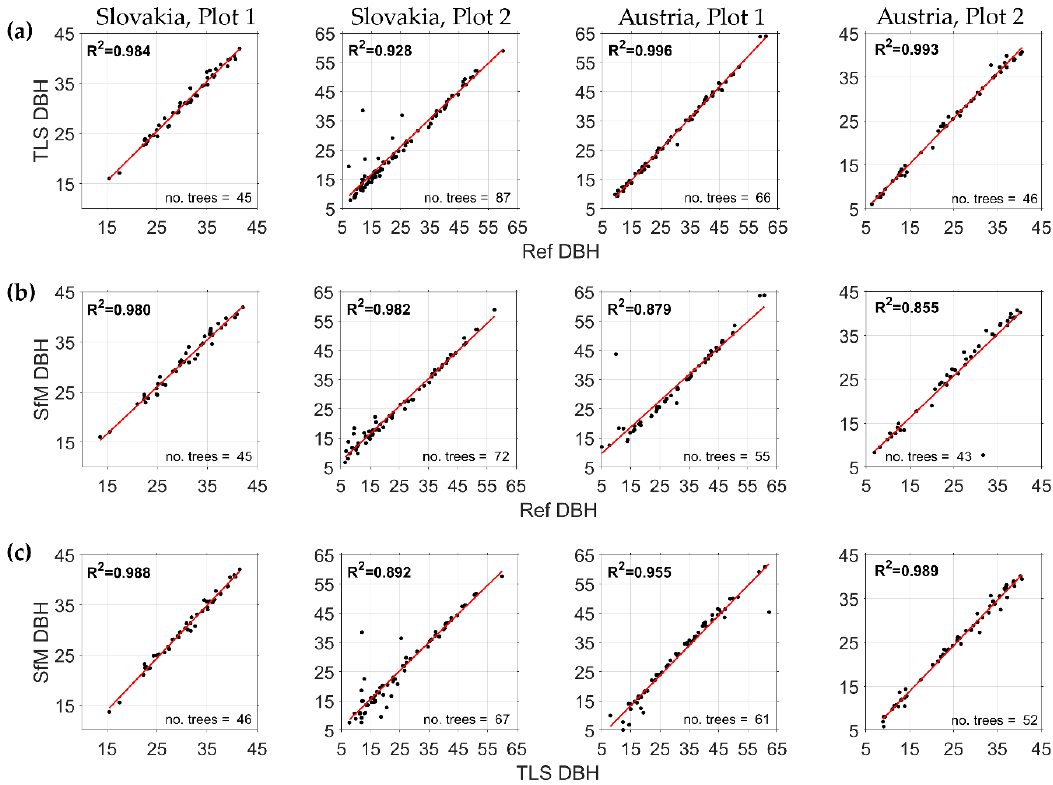
Figure A3. For all the forest plots, the scatterplot of the DBH estimates from ( a ) TLS and ( b ) SfM with respect to the caliper measurements and ( c ) from the SfM with respect to the TLS estimates.